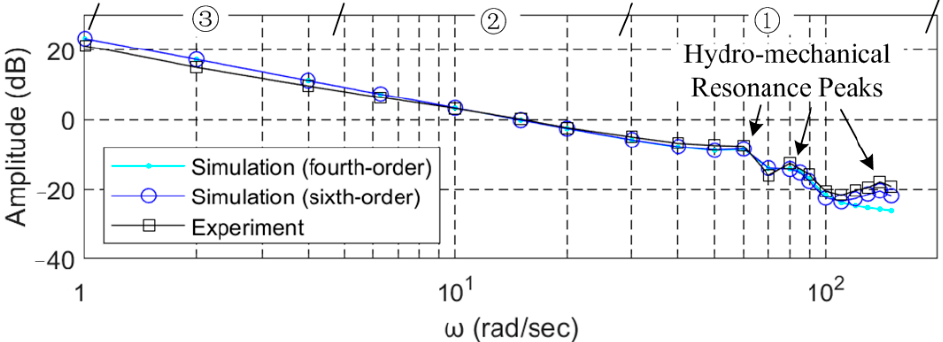
Figure 16. The open loop dynamics of the piston position X p loop.